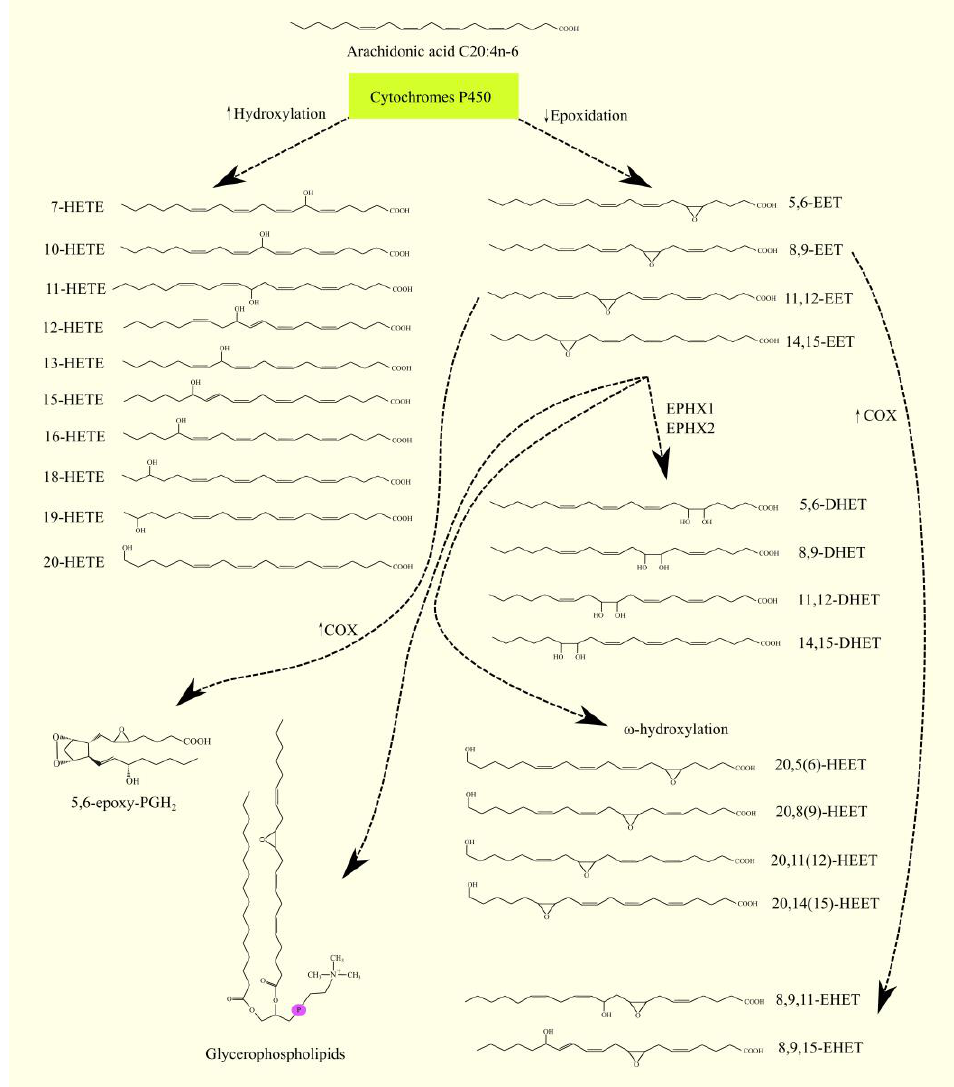
Figure 7. Cytochrome P450 pathway. ARA 20:4n-6 can be converted in the cytochrome P450 pathway, resulting in the formation of various ETT and HETE. ETT can undergo further transformations where they are incorporated into glycerophospholipids in the sn -2 position; in this form, they build the cell membrane and intracellular membranes. In addition, the epoxide bond in ETT can be transformed by EPHX1 and EPHX2 into two hydroxyl groups, resulting in the formation of various DHET. ETT can also undergo ω -hydroxylation, which results in the formation of various HEET. ETT can be converted with COX. 5,6-EET then produces 5,6-epoxy-PGH 2 , whereas 8,9-EET produces either 8,9,11-EHET or 8,9,15-EHET. ↑ — higher expression of given enzymes in GBM tumor relative to healthy tissue; ↓ — lower expression of given enzymes in GBM tumor relative to healthy tissue.